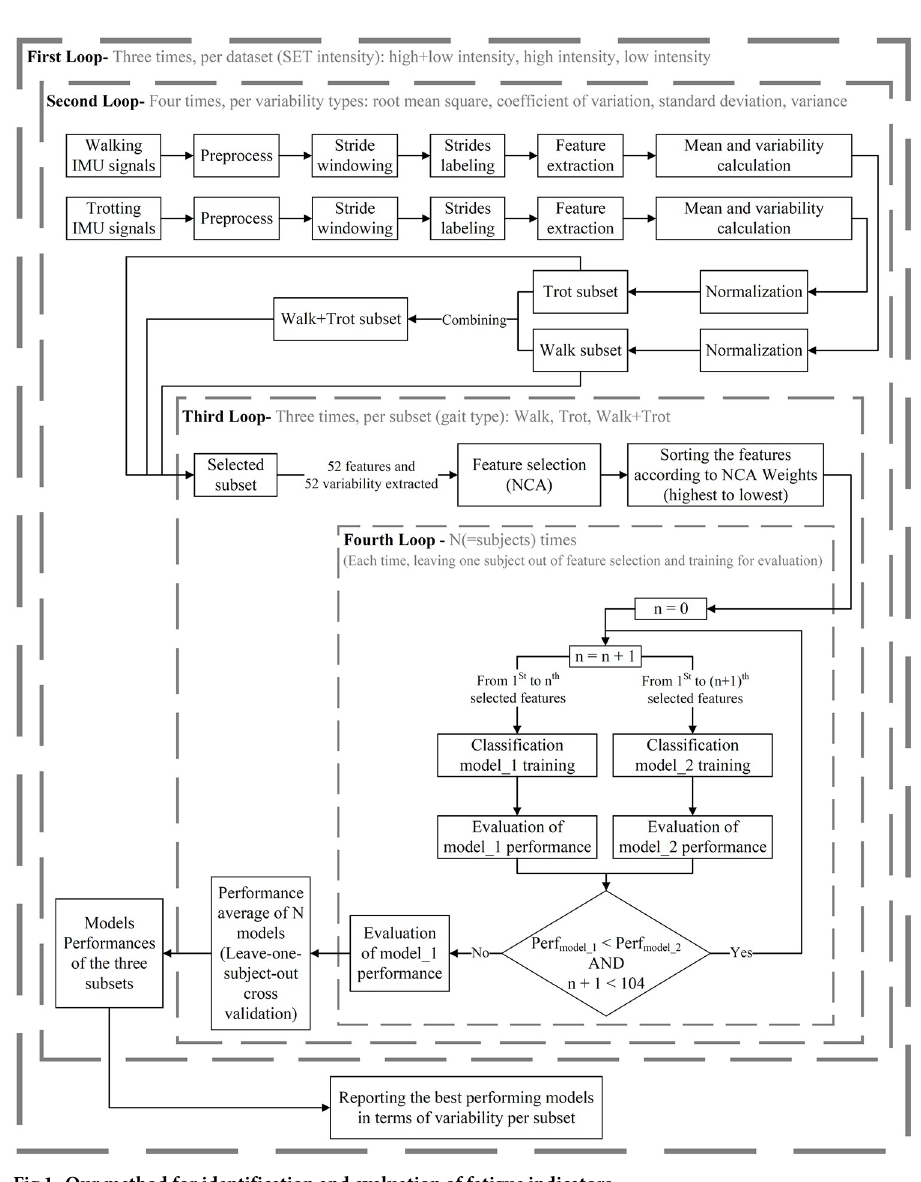
Fig 1. Our method for identification and evaluation of fatigue indicators.